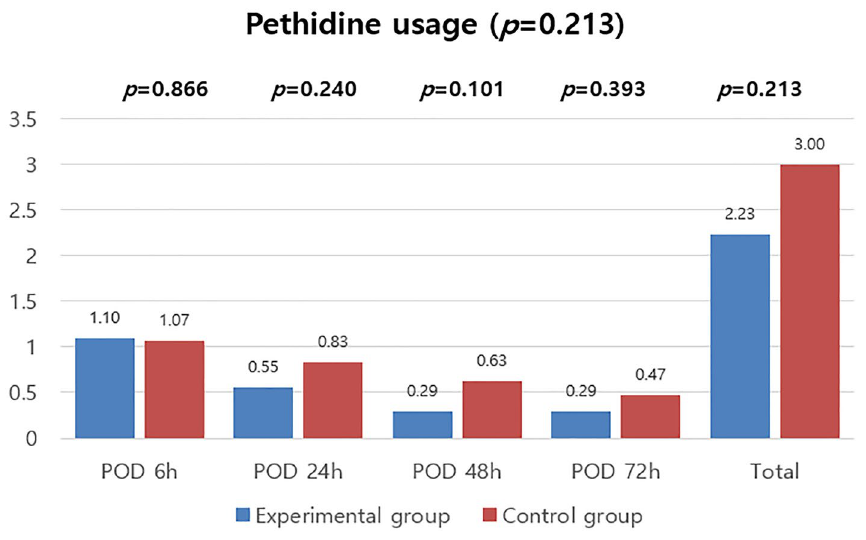
Figure 3. Amount of rescue analgesic